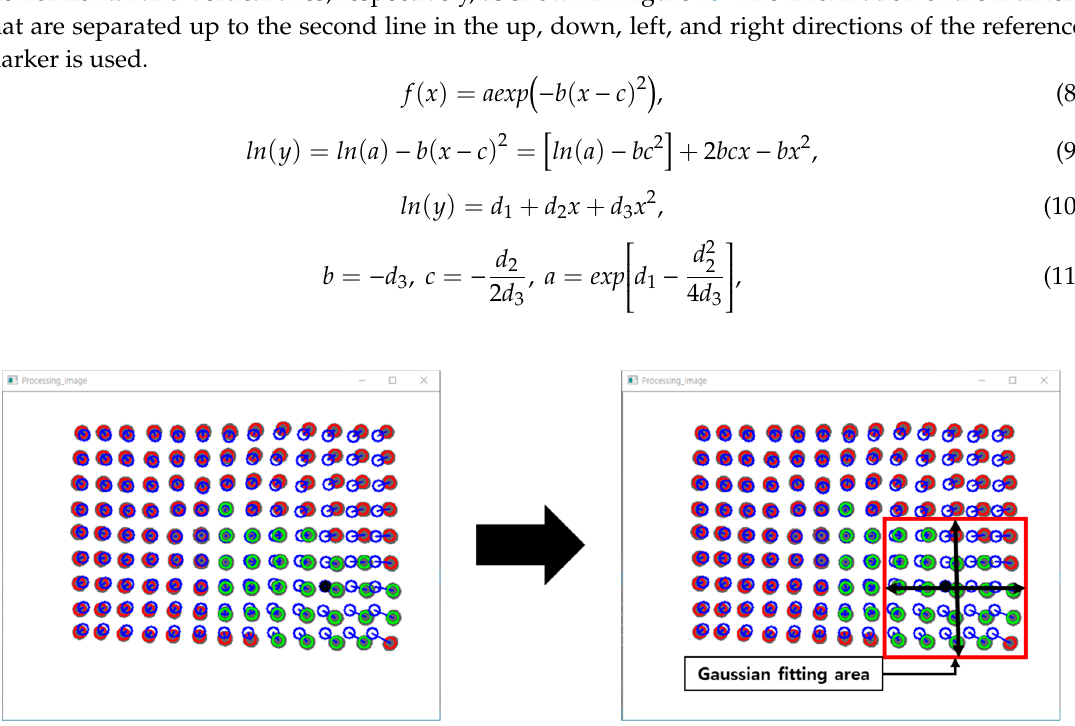
Figure 13. Target areas for Gaussian fitting algorithm.